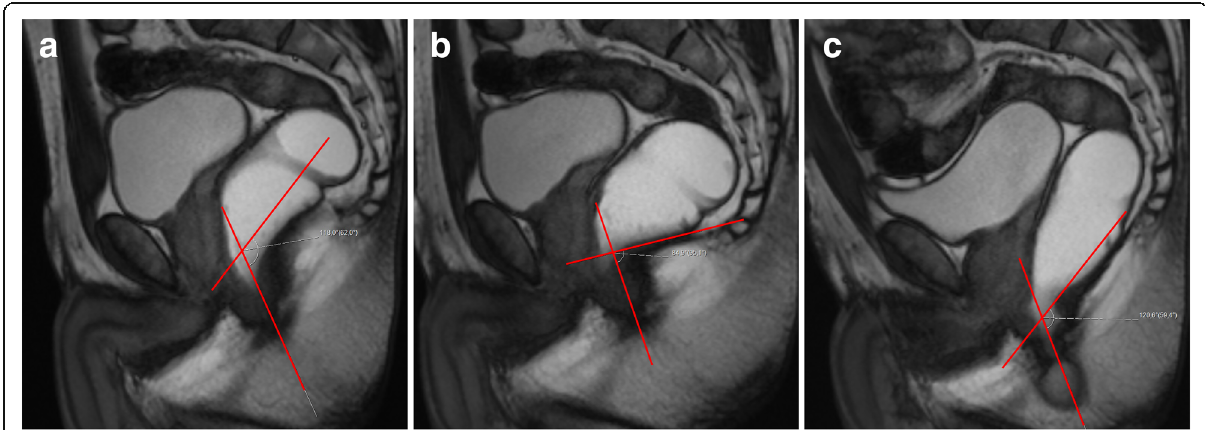
Fig. 22 Spastic pelvic floor syndrome. ( a , b , c ) Sagittal midline TrueFISP images of a man at rest ( a ), during squeezing ( b ) and evacuation ( c ), demonstrating a normal ARA angle at rest in ( a ) (118°), but revealing an increased reduction during squeezing in ( b ) (85°) and a lack of normal widening in the evacuation phase ( c ) (120°). During the dynamic evaluation, spastic contractions of the puborectalis muscle during evacuation were noted as well, and an incomplete evacuation with retention of ultrasound gel was present, all signs compatible with paradoxical contraction of the puborectalis